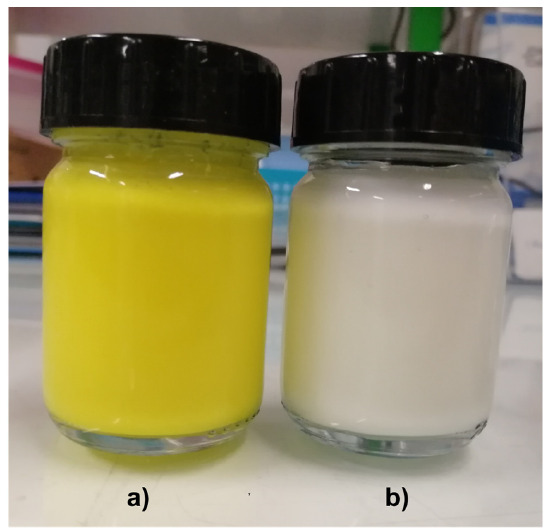
Figure 4. Yogurt with curcumin ( a ) and control yogurt (i.e., plain yogurt) ( b ).